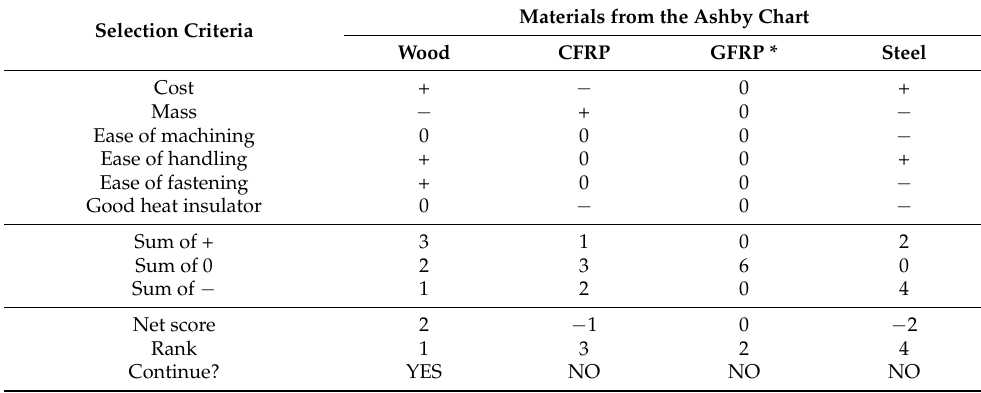
Table 17. Screening of materials selected from “Bubble Chart”.